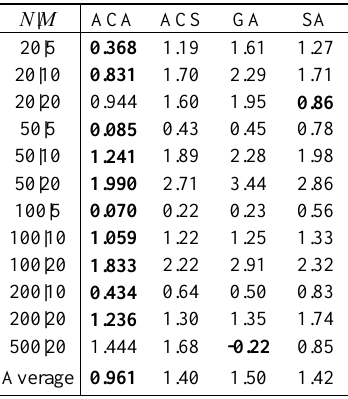
Table 2. Comparison of the ACA with ACS, GA and SA.